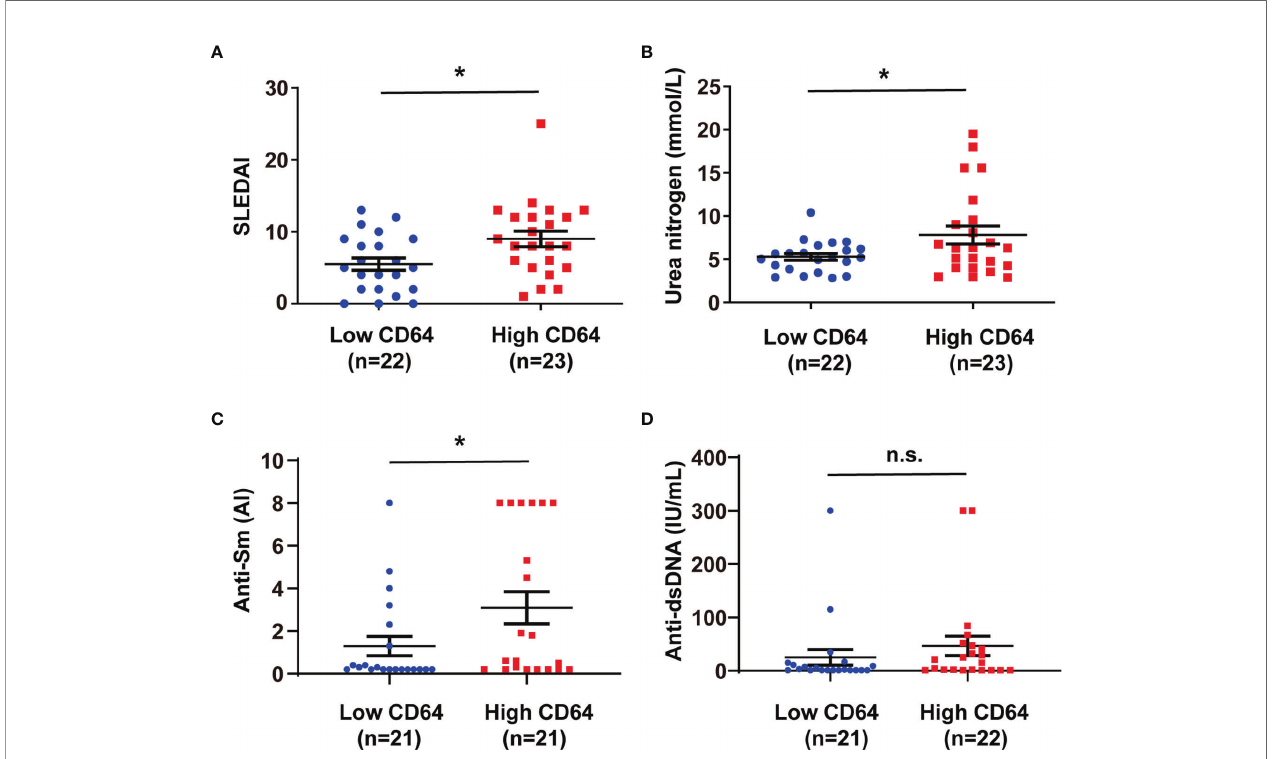
FIGURE 2 | CD64 expression in monocytes correlated with SLEDAI, anti-Sm antibodies and blood urea nitrogen levels in SLE. SLE patients were classi fi ed into low and high CD64 groups, and the analysis of their SLEDAI (A) , blood urea nitrogen (B) , anti-Sm antibodies (C) and anti-dsDNA antibodies (D) were presented. 21 of 22 low CD64 patients were tested anti-dsDNA and anti-Sm; 21 of 23 high CD64 patients were tested anti-Sm; 22 of 23 high CD64 patients were tested anti- dsDNA. *p < 0.05; n.s., not signi fi